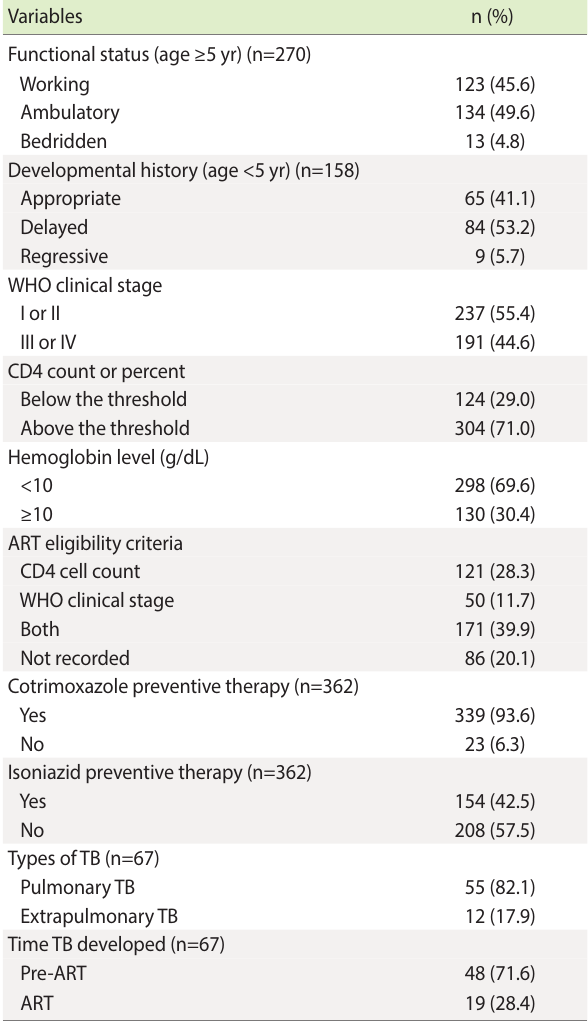
Table 2. Baseline clinical, laboratory, and ART information for chil-